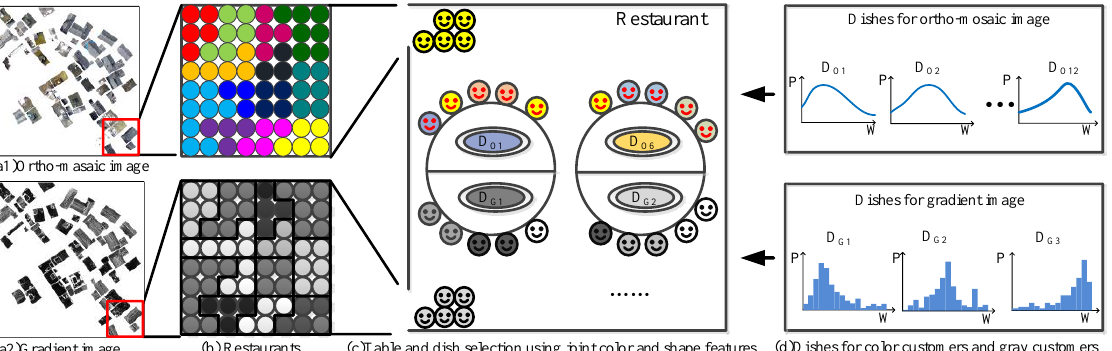
Figure 7. An illustration of the roof-hole detection based on the CRF model .